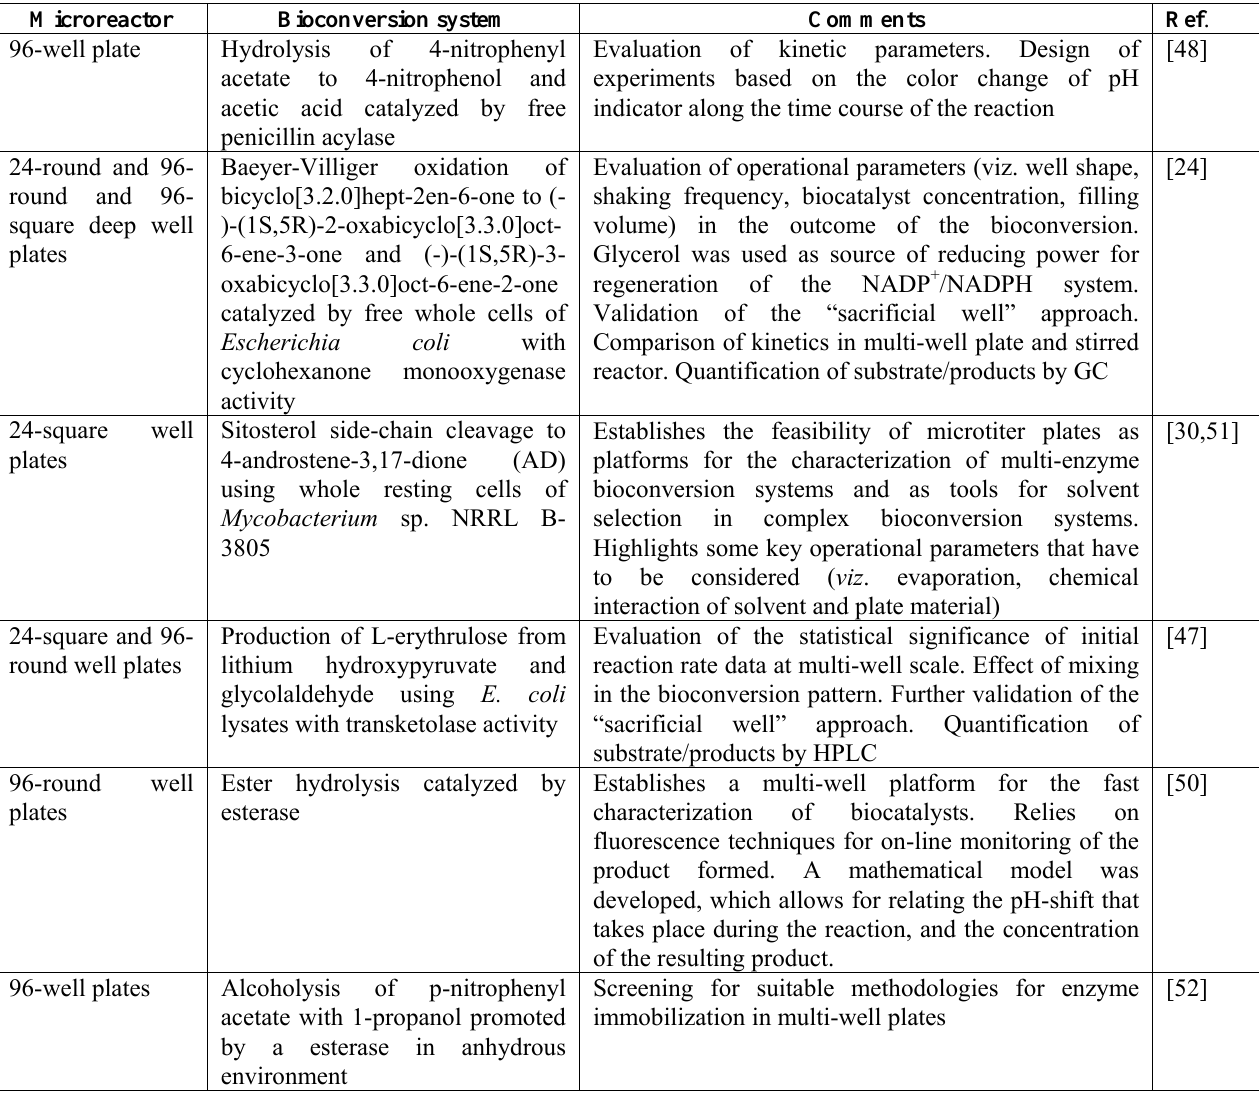
Table 2. Characterization of bioconversion systems using multi-well plates.